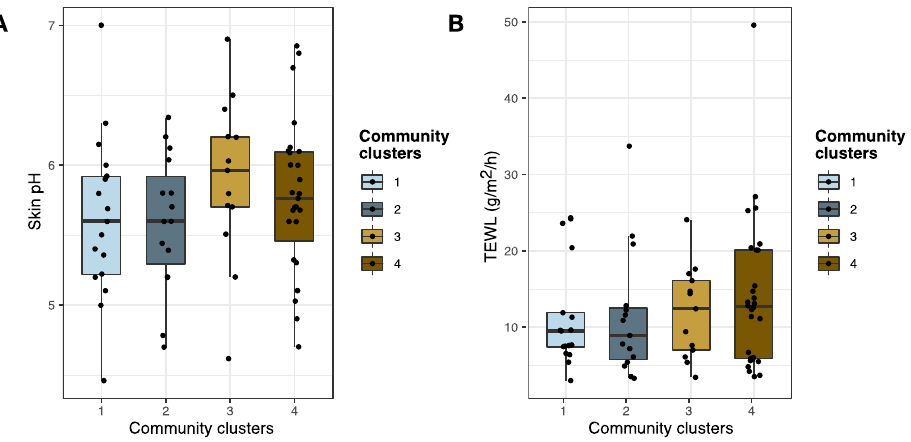
Figure 5. Skin barrier function (pH and TEWL) and cutaneous staphylococcal communities . Skin pH ( A ) and TEWL ( B ) and their association to staphylococcal community cluster assignment of non-lesional AD skin ( n = 73). Boxplots represent the median and interquartile range (IQR) with whiskers extending to the minimum/maximum value, but no longer than 1.5xIQR. Abbreviations: AD: atopic dermatitis; TEWL: transepidermal water loss.